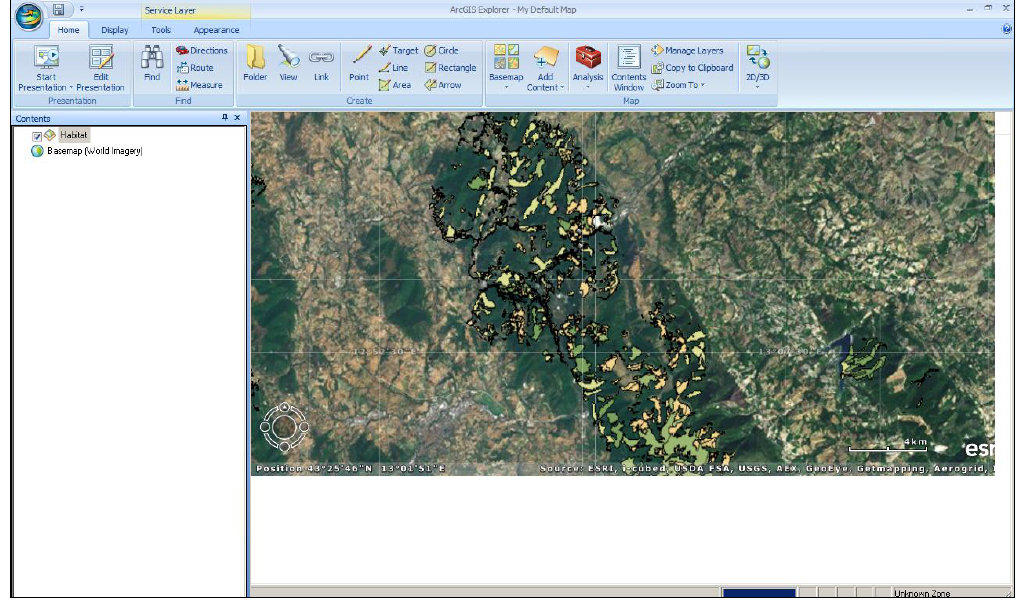
Figure 2. Example of ArcGIS Explorer interface reading WMS from SIT